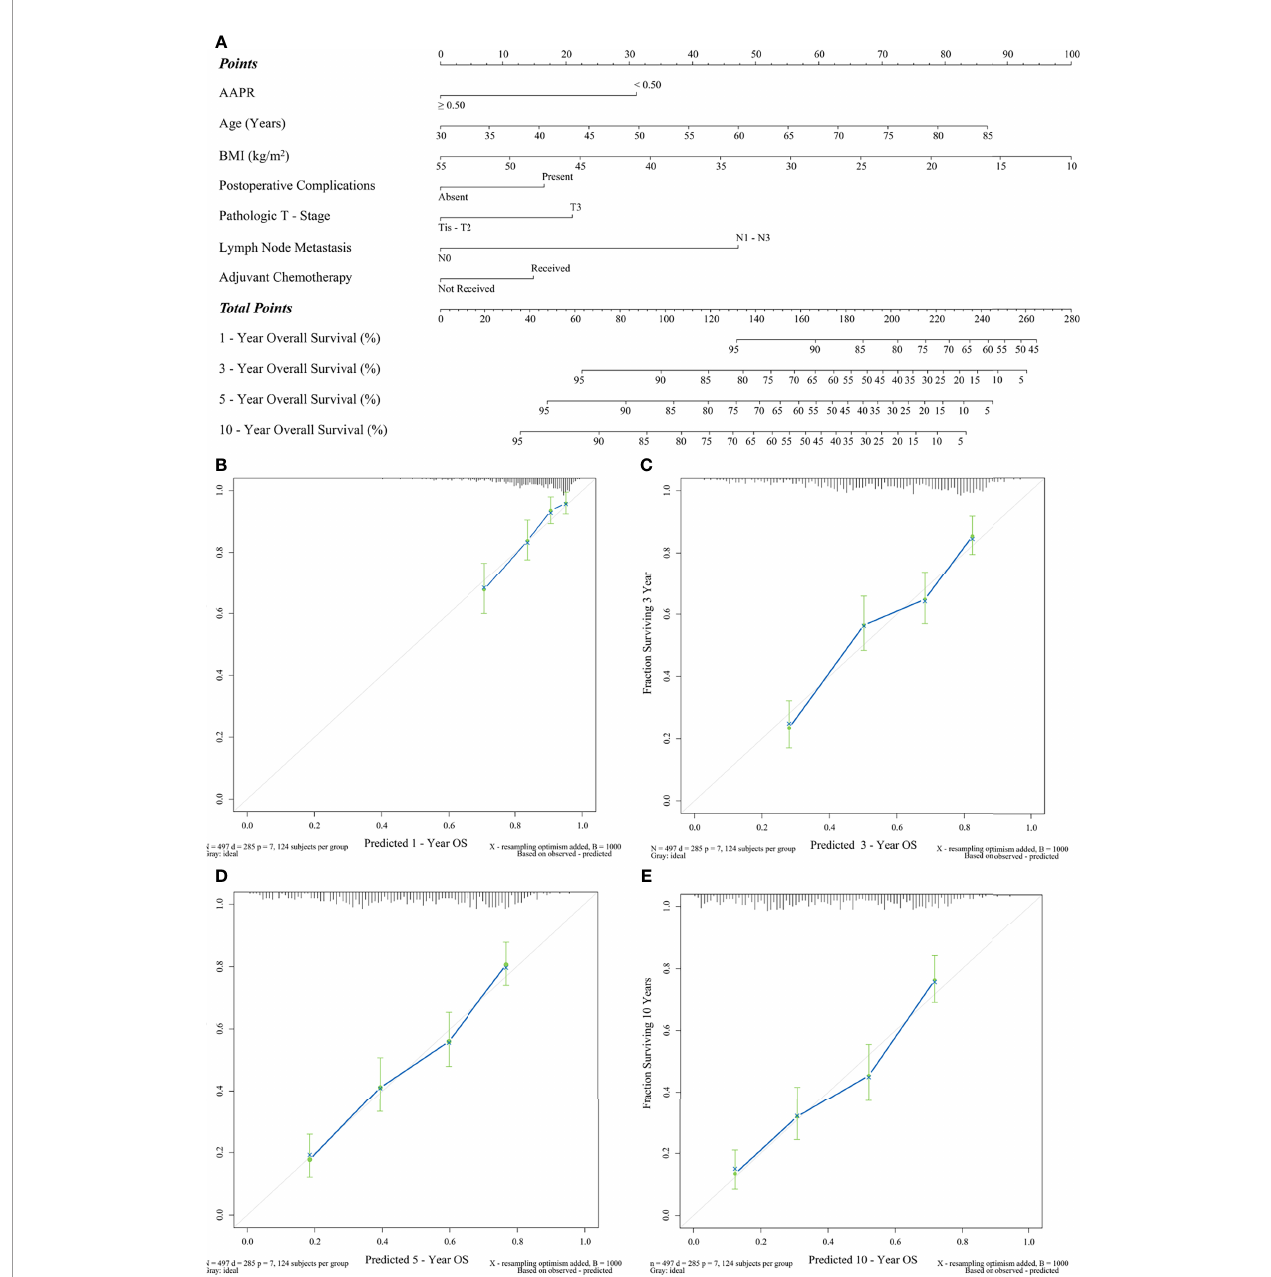
FIGURE 5 | Prediction of OS by preoperative AAPR. (A) AAPR composite nomogram and its calibration curves (B) 1-year OS, (C) 3-year OS, (D) 5-year OS, and (E) 10-year